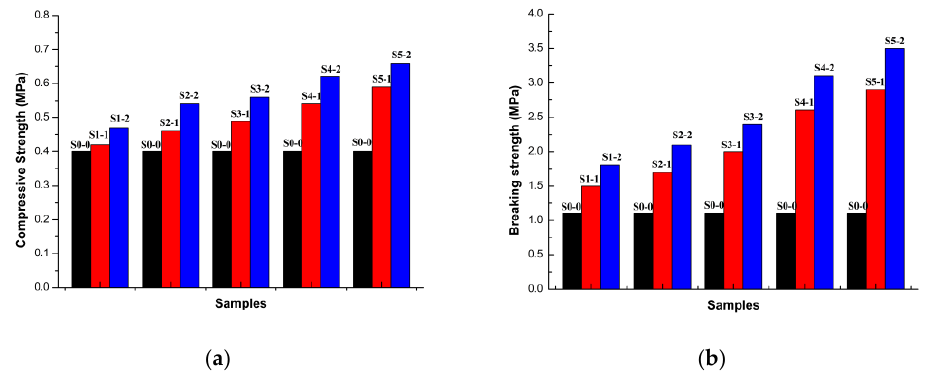
Figure 7 Figure 7. Mechanical property (28 days). ( a ) Compressive strength, ( b ) breaking